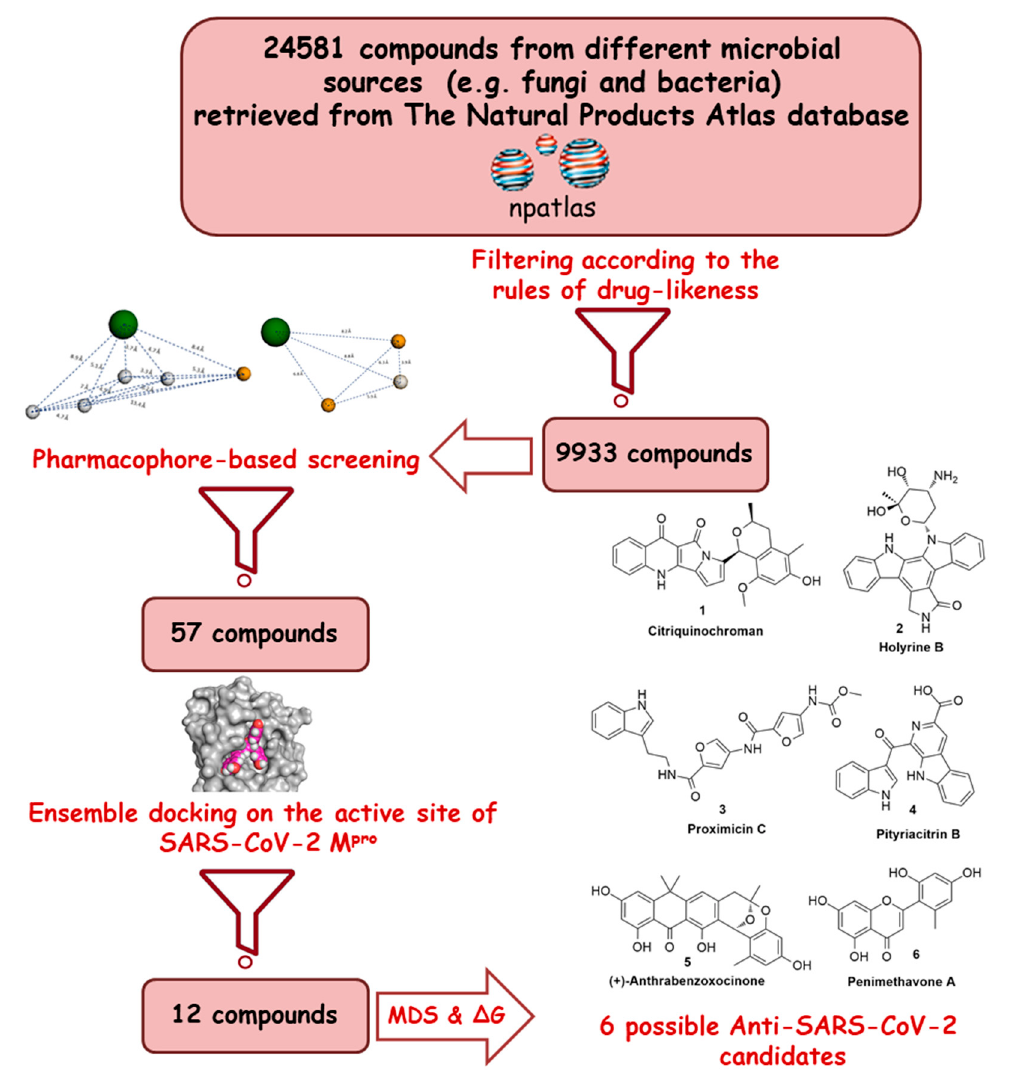
Figure 1. Applied strategy in the present study.